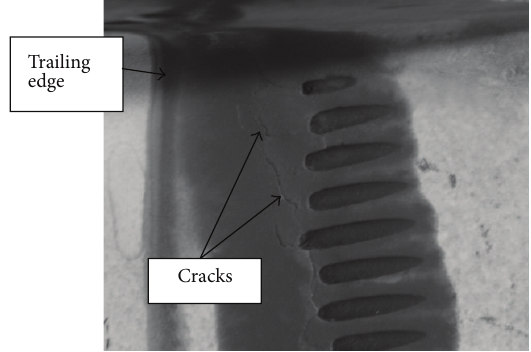
Figure 4: Cracks on the nozzle vane near the internal shroud close to the trailing